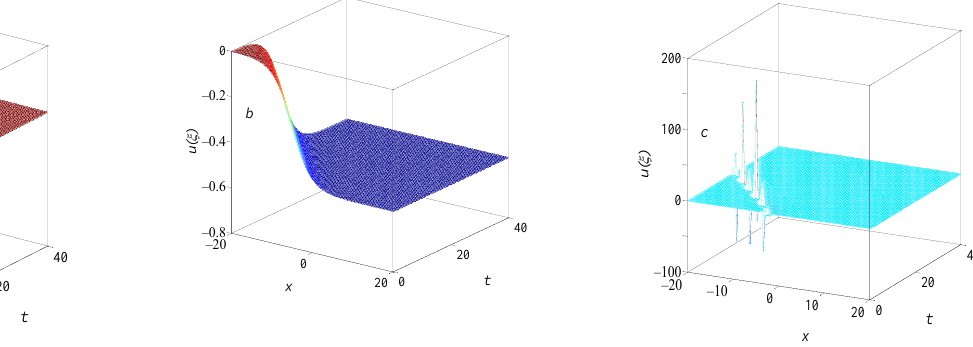
6𝑘 2 𝐴 where 𝜉 = 𝑘𝑥 + 𝜆𝑡 , 𝜆 = − , 𝑘 = ± , and 𝑟 ≠ ±1 . These two sets of solutions contain 𝜂 2 2 many kinds of solitary-wave solutions due to the different values of r ; for example, if 𝑟 = (𝜉) = ±√2𝑘 ∓ √2𝑘 𝑐𝑜𝑡ℎ(𝜉) , they represent the singular solitary-wave solutions 0 , 𝑢 111 (see Figure 4c), and these solutions are the same as Equations (14) – (21) in ref. [20]. In this reference, the Riccati equation is used as an auxiliary equation to solve the Van der Waals normal form. When 𝑟 = 2 and 𝑘 = −0.189, Equation (28) shows kink solitary-wave solutions (see Figure 4a). If 𝑟 = 2 and 𝑘 = 0.189 , Equation (28) shows the anti-kink solitary wave solutions (see Figure 4b). Figure 3. ( a ) Three-dimensional and ( b ) two-dimensional plots represent the anti-kink solitary-wave solution of Equation (20) when η = 1, ε = 1, r = 1, and k = 0.189.